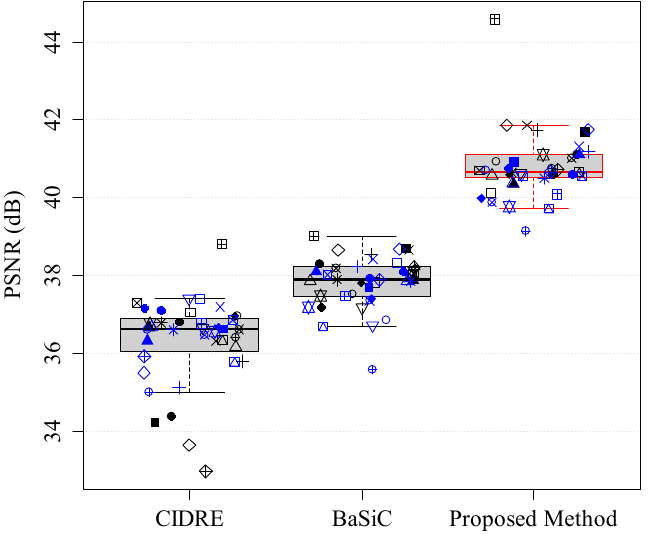
Figure 12. Peak signal-to-noise ratio (PSNR) of CIDRE, BaSiC and the proposed method.